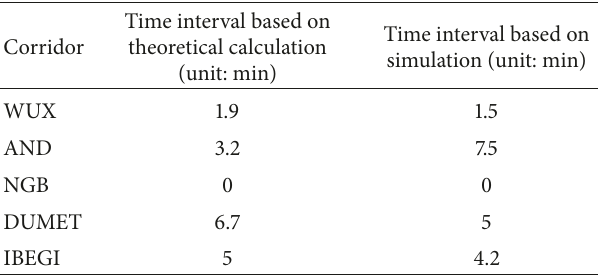
Table 11: Time interval comparison between simulation data anal- ysis and theoretical calculation at approach corridor.